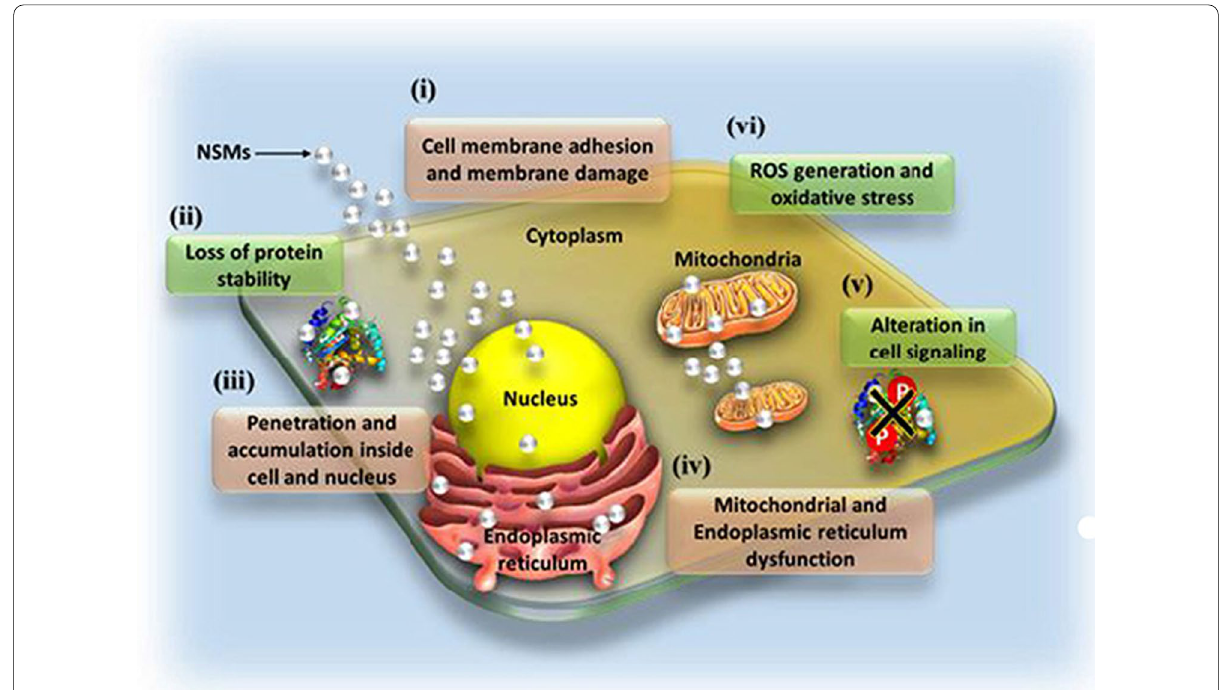
Fig. 8 Antimicrobial mode of actions of the NSMs. Various NSMs can induce cell death by altering various biological functions, X represents alteration of cell signaling by de-phosphorylation of tyrosine residues in proteins as one of the mechanisms. Reproduced with permission